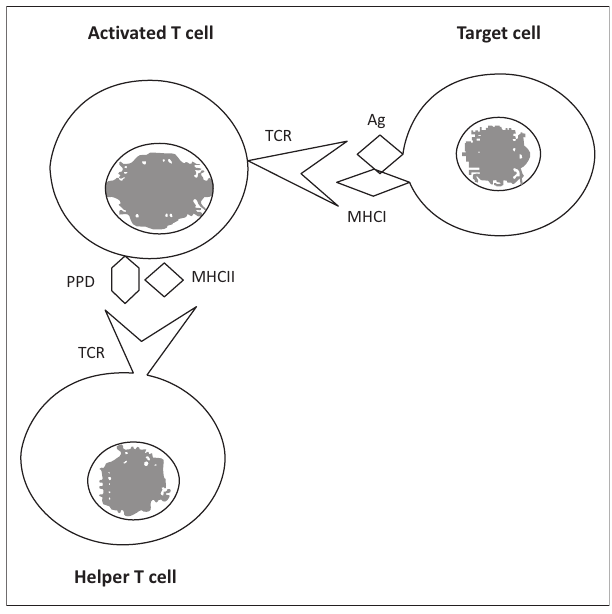
PPD, purified protein derivative. Note: The PPD pulsed on activated (MHCII+) anti-COV2 cytotoxic T-cell is recognised by the mycobacterial antigen – specific T H cell of a BCG primed host leading to amplification of the former, which can then overpower the virus infected target cells. FIGURE 1: Diagrammatic representation of purified protein derivative mediated selective in vivo amplification of a T-cell.